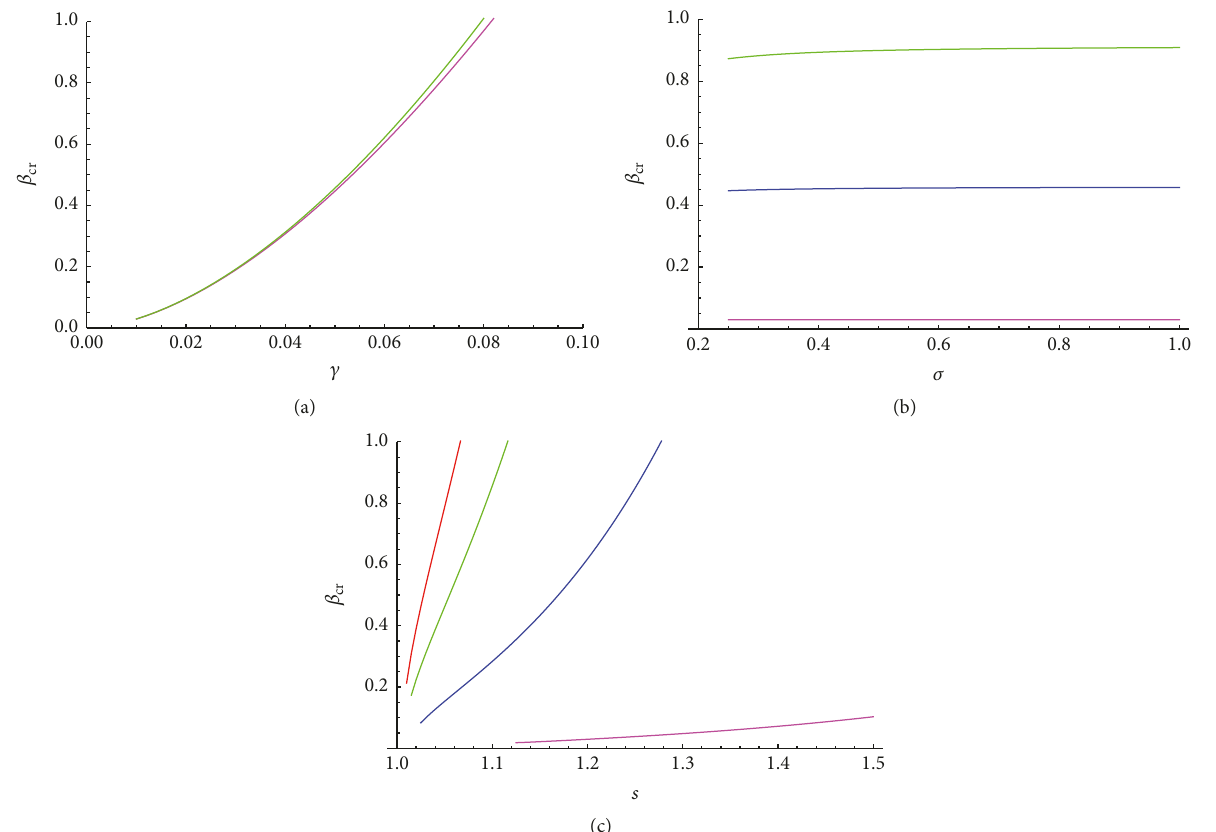
Figure 1: The critical value, 𝛽 cr , as a function of the parameters: (a) 𝛾 for 𝜎 = 0.25 (magenta) and 𝜎 = 0.75 (green), (b) 𝜎 for 𝛾 = 0.01 (magenta), 𝛾 = 0.05 (blue), and 𝛾 = 0.075 (green), and (c) 𝑠 for 𝜎 = 0.5 and 𝛾 = 0.01 (magenta), 𝛾 = 0.06 (blue), 𝛾 = 0.12 (green), and 𝛾 = 0.17 (red).